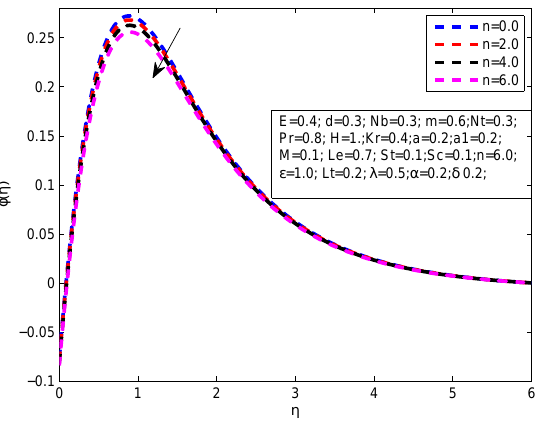
Figure 19. Variation of φ for distinct values of n